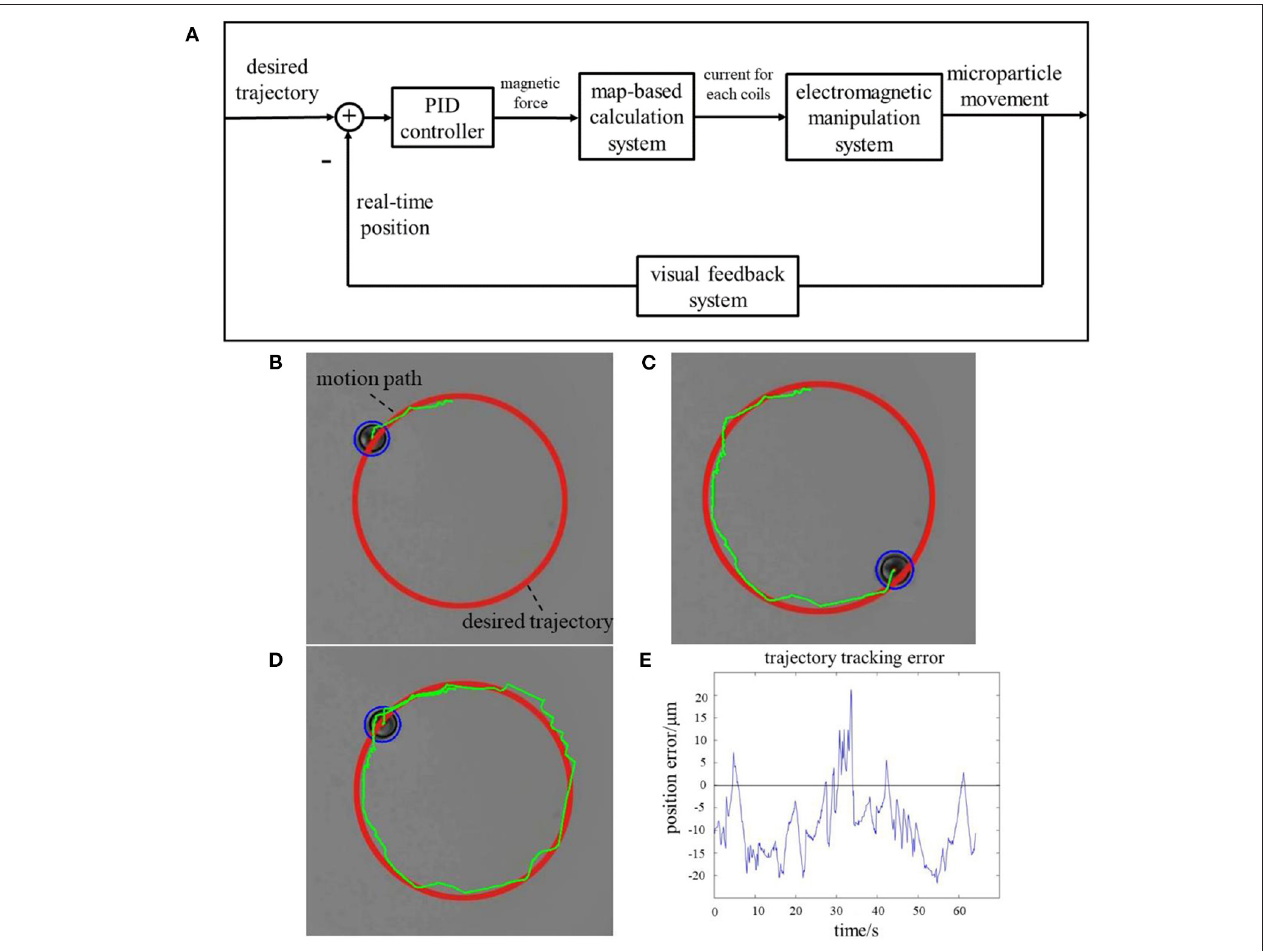
FIGURE 4 | (A) Micro-particle control schematic. Captured images for manipulating a micro-particle along desired circular path at different moments: (B) at t = 5s; (C) at t = 25s; (D) at t = 40s; (E) trajectory tracking